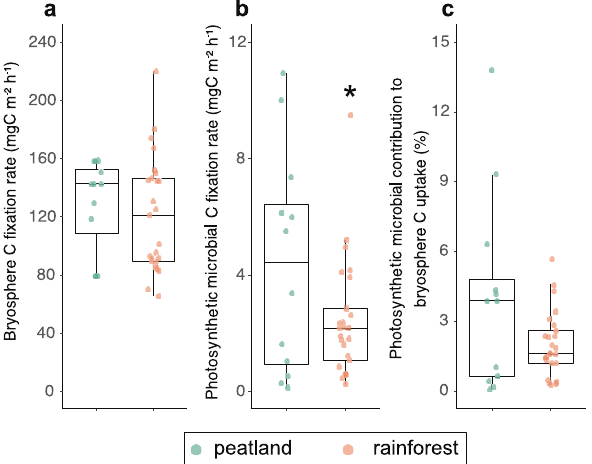
Fig. 4 Photosynthetic microbial contribution to bryophyte C uptake. Microbial C fi xation ( a ), bryosphere C fi xation ( b ) and contribution of photoautotrophs to bryosphere C fi xation ( c ) in both types of bryosphere. Signi fi cant differences ( P < 0.05, ANOVA type III) are indicated by asterisks.